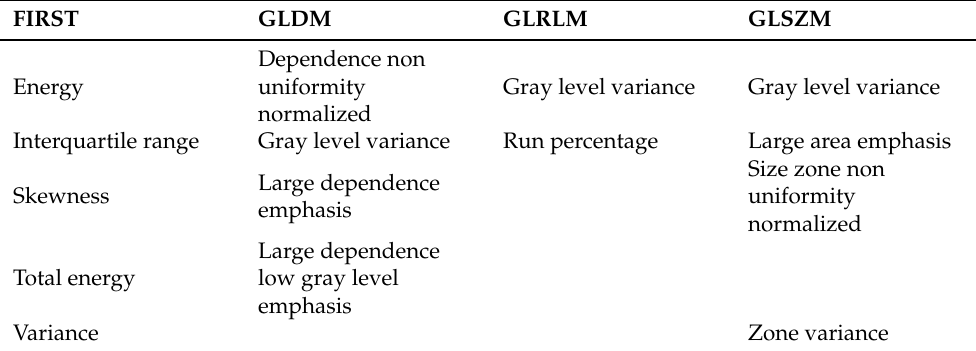
Table 1. Radiomic feature set for the first tier (or step 1).